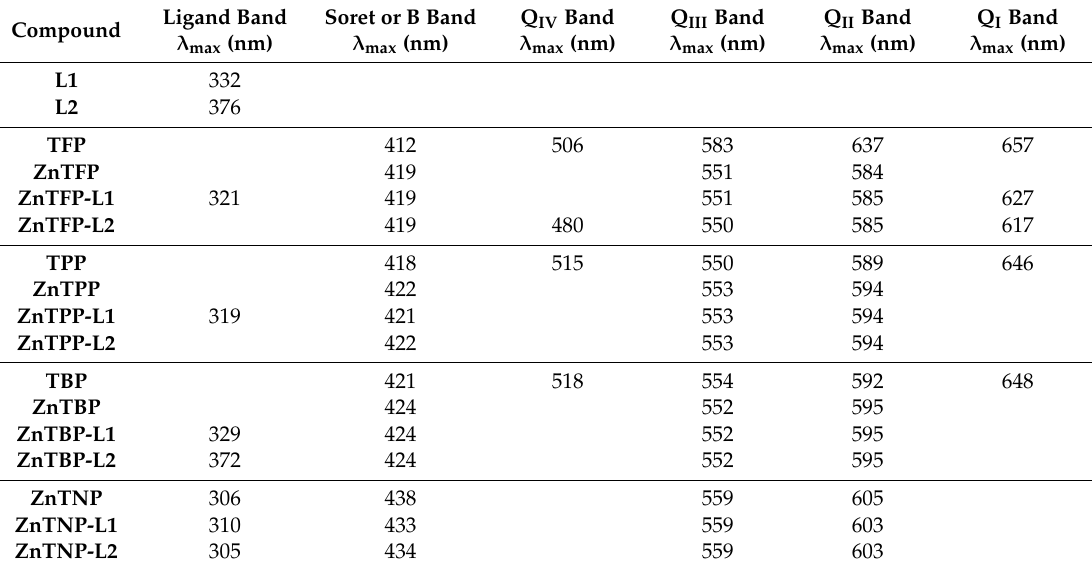
Table 1. Electronic absorption data in CHCl 3 solution of ligands acceptor –NO 2 ( L1 ) and donor –NMe 2 ( L2 ) and of the axially coordinated A 4 Zn II